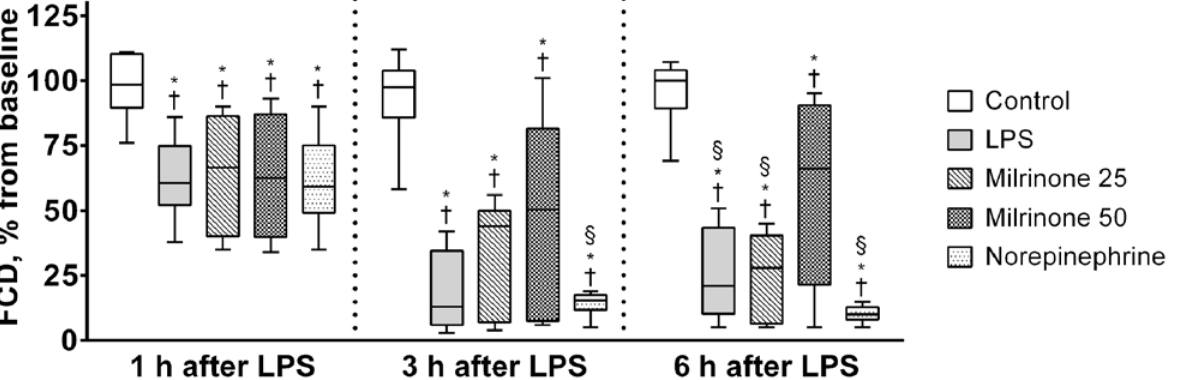
Fig 4. Evolution of functional capillary density (FCD) during the experimental period. Values of FCD are presented as ratios relative to baseline values. Sequential measurements were performed after one, three, and six hours of LPS injection. Control, non-endotoxemic animals (n = 10); LPS, endotoxemic animals (n = 10); Milrinone 25, endotoxemic and milrinone 0.25 μ g.kg -1 .min -1 treated animals (n = 10); Milrinone 50, endotoxemic and milrinone 0.50 μ g.kg -1 .min -1 treated animals (n = 10); Norepinephrine, endotoxemic and norepinephrine treated animals (n = 10). † p < 0.05 vs . group baseline; * p < 0.05 vs . Control group at the same time point; § p < 0.05 vs . Milrinone 50 group at the same time point.